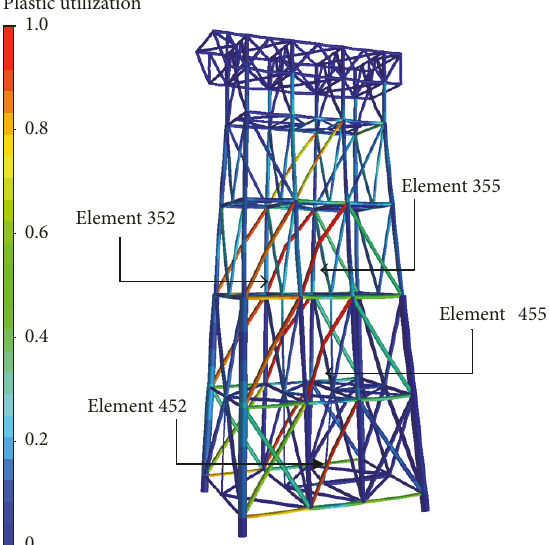
Figure 13: Plasticity utilization